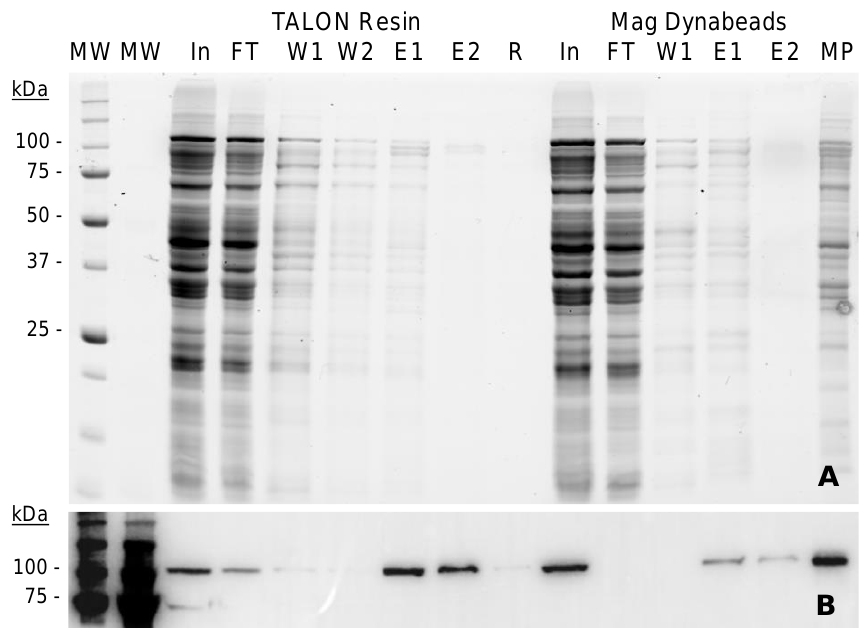
Figure 4. Comparison of TALON resin and magnetic Dynabeads for MVP-H6 purification. Samples were analyzed by ( A ) SDS-PAGE and TGX visualization, and ( B ) Western blot developed with a monoclonal antibody against His-tag. Legend: initial sample (In), flowthrough (FT), first wash (W1), second wash (W2), elution with 250 mM imidazol (E1) and with 2 M imidazol (E2). R and MP correspond, respectively, to samples of resin and magnetic particles after elution steps, in order to evaluate amounts of protein not eluted and still attached to the purification support. MW: molecular weight standard.